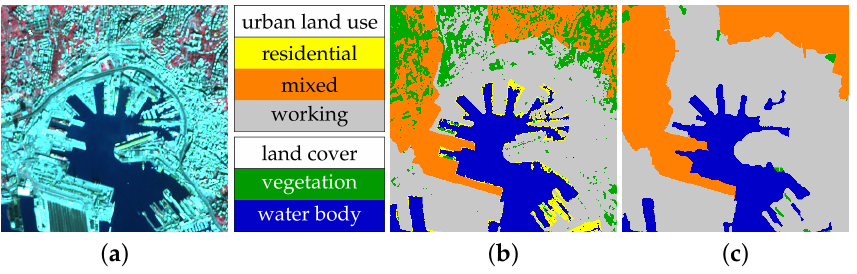
Figure 11. Details of ( a ) the Sentinel-2 false colour composite and the classification maps generated by ( b ) the proposed pixelwise decision fusion method and ( c ) the developed Markovian region-based technique. Size of the crop area: 300 ˆ 300 pixels, 3 km ˆ 3